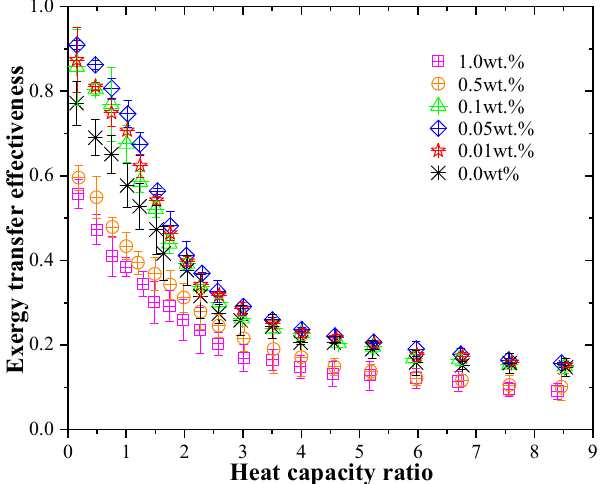
Figure 9. Effects of nanofluids mass fraction on exergy transfer effectiveness at different heat capacity ratios.